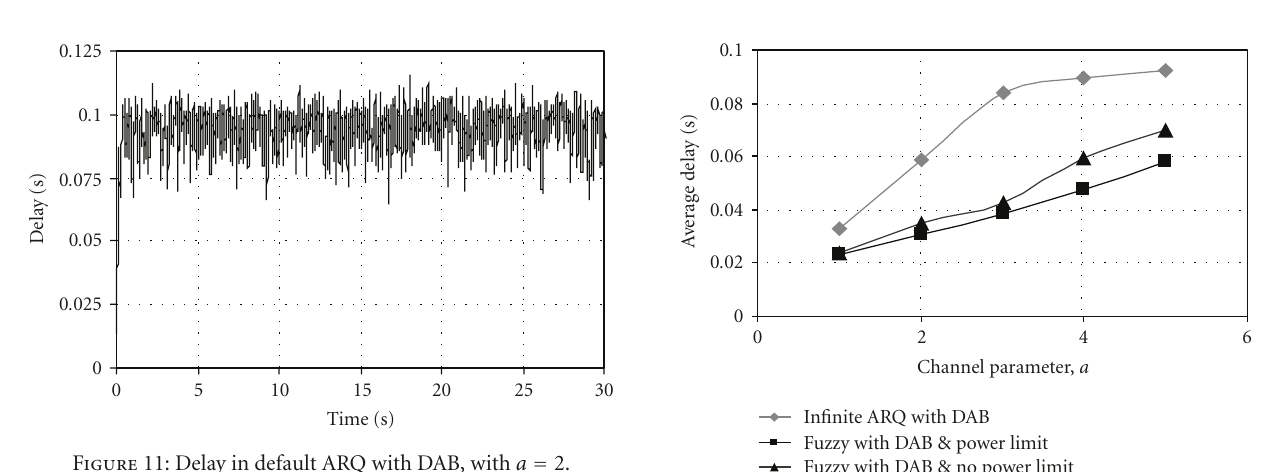
Figure 11: Delay in default ARQ with DAB, with a = 2.